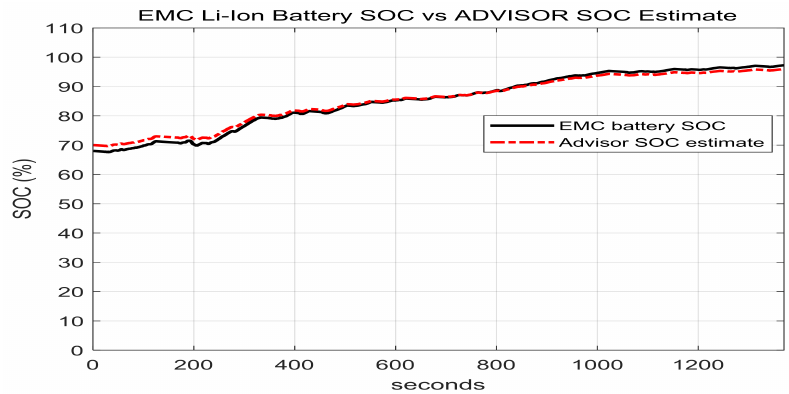
Figure 13. The 2RC EMC Li-Ion battery SOC versus ADVISOR SOC estimate.